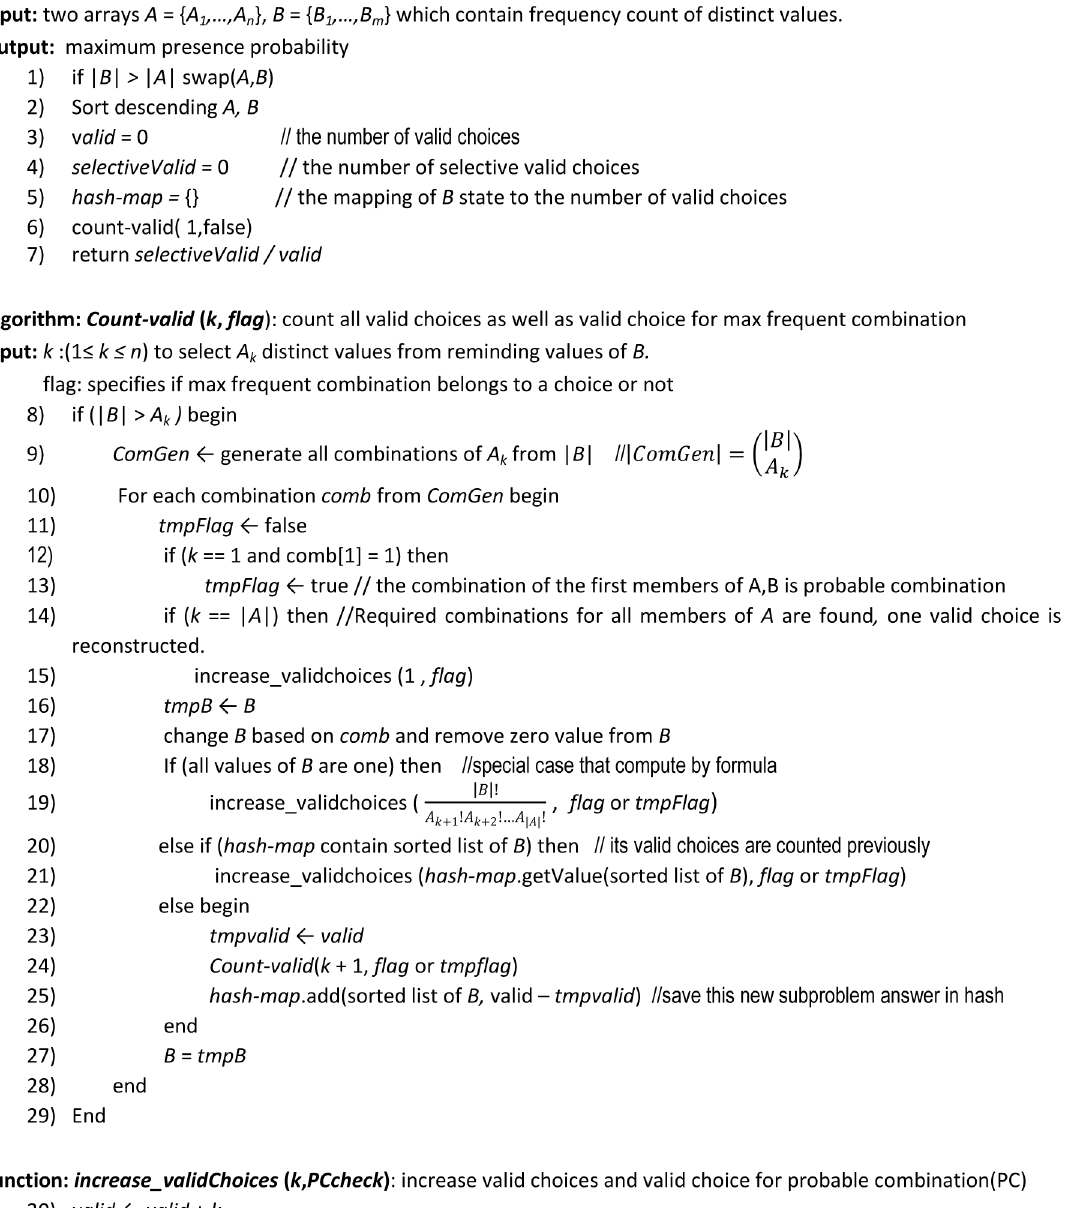
Fig 4. Recursive function for computing presence